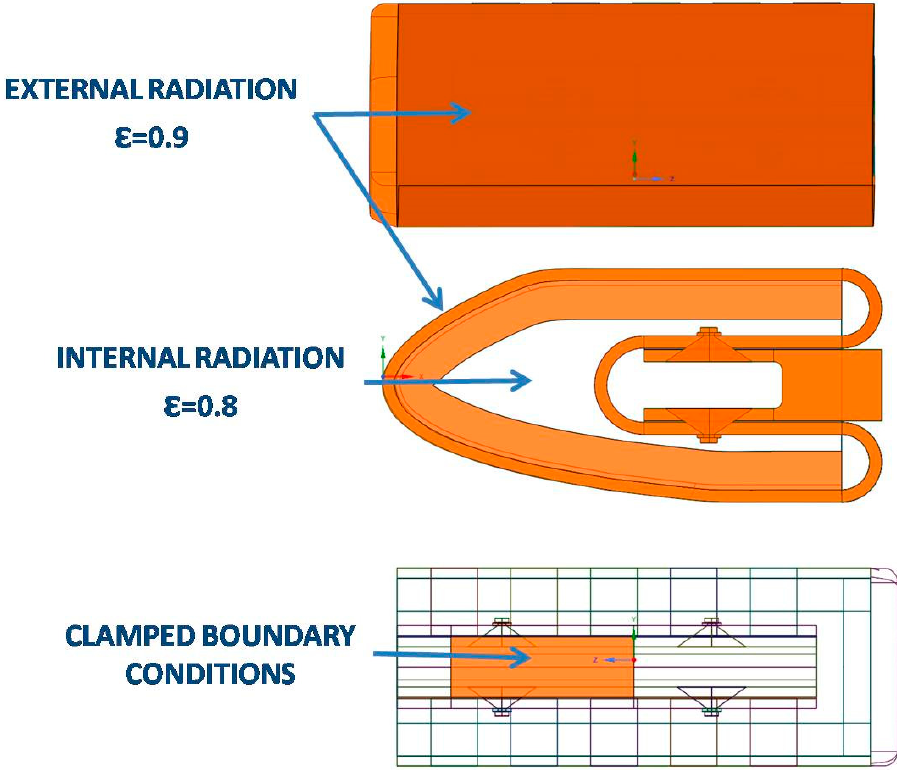
Figure 5. Thermal and structural boundary conditions.